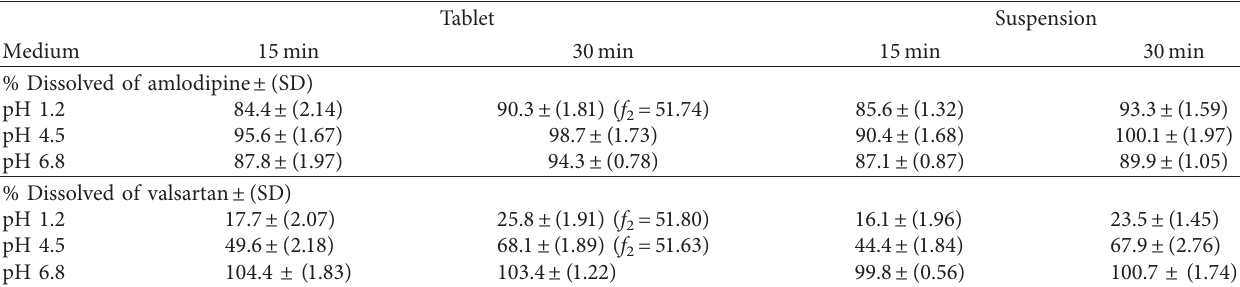
Figure 2: Release profiles of AML from the tablet and the suspension at different pH values (a) and of VAL from the tablet and the suspension at different pH values (b). Table 3: Dissolution of AML and VAL from Valzadepine ® tablets and extemporaneous suspension at different pH values and two time